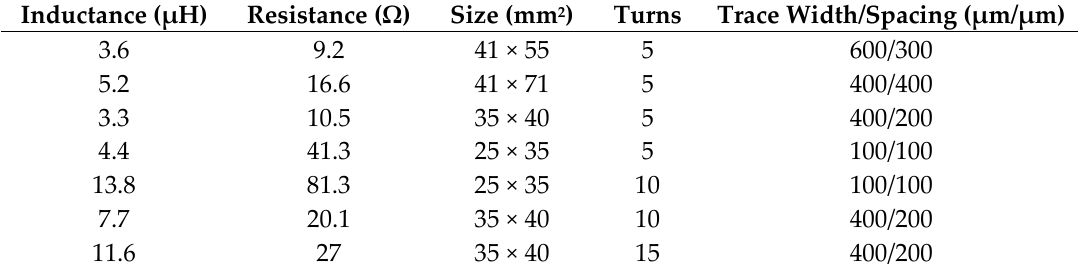
Figure 5. ( a ) Measurement setup to show the linearity of the on-foil p-type organic TFT switches by measuring the total harmonic distortion. Sine-wave signal of frequency 3 kHz and amplitude of Vrms = 100 mV is applied to the source of the p-channel TFT and the drain is monitored using a spectrum analyzer as plotted in ( b ). Table 1. The on-foil inductors electrical